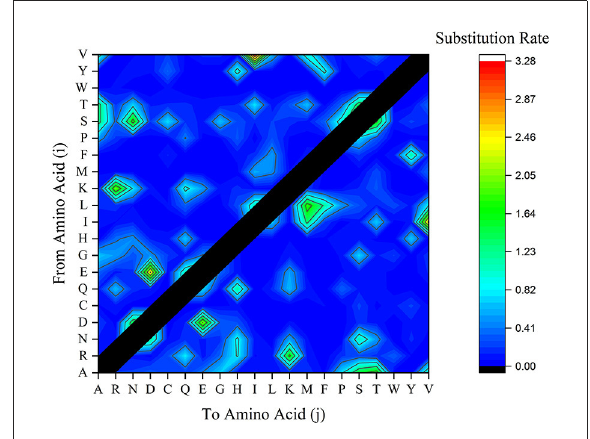
FIGURE9 Substituted amino acids rate within BFDV sequences of all rep or cap sequences including sequences from GenBank and this